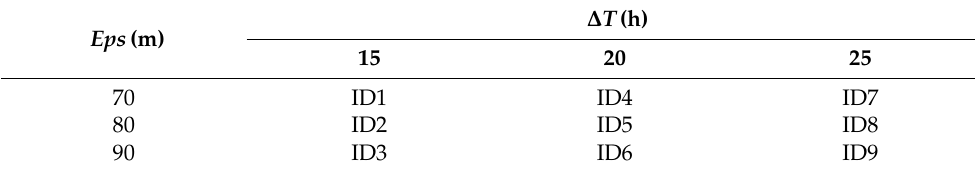
Figure 8. 9-Dist graph. ( a ) Spatial distance. ( b ) Temporal distance. By observing Figure 8, the vertical axis coordinate values corresponding to the two inflection points are 80 and 20, respectively. However, considering the influence of human factors, there may be subjective errors in the vertical axis coordinate values. In order to find the parameters with the best clustering results, different distance values corresponding to inflection points were selected to carry out the parameter combination clustering tests. Eps was taken as [70 80 90], and ∆ T was taken as [15 20 25]. In Table 2, nine parameter combinations can be obtained based on the different values of Eps and ∆ T , numbered ID1 to ID9. respectively. Table 2. Parameter combinations of Eps and ∆ T .